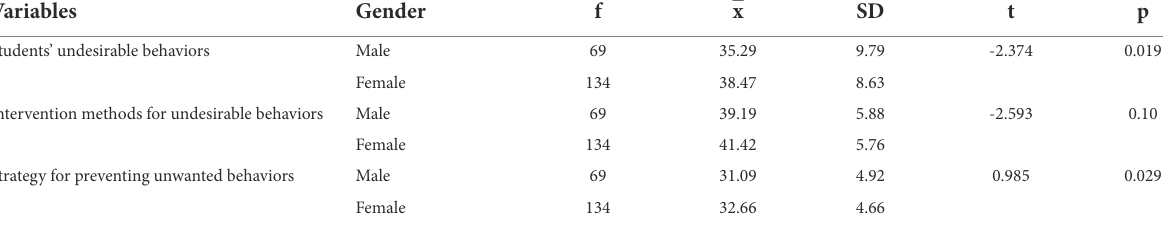
TABLE 2 Differentiation of total scores obtained from variables by gender. Variables Students’ undesirable behaviors